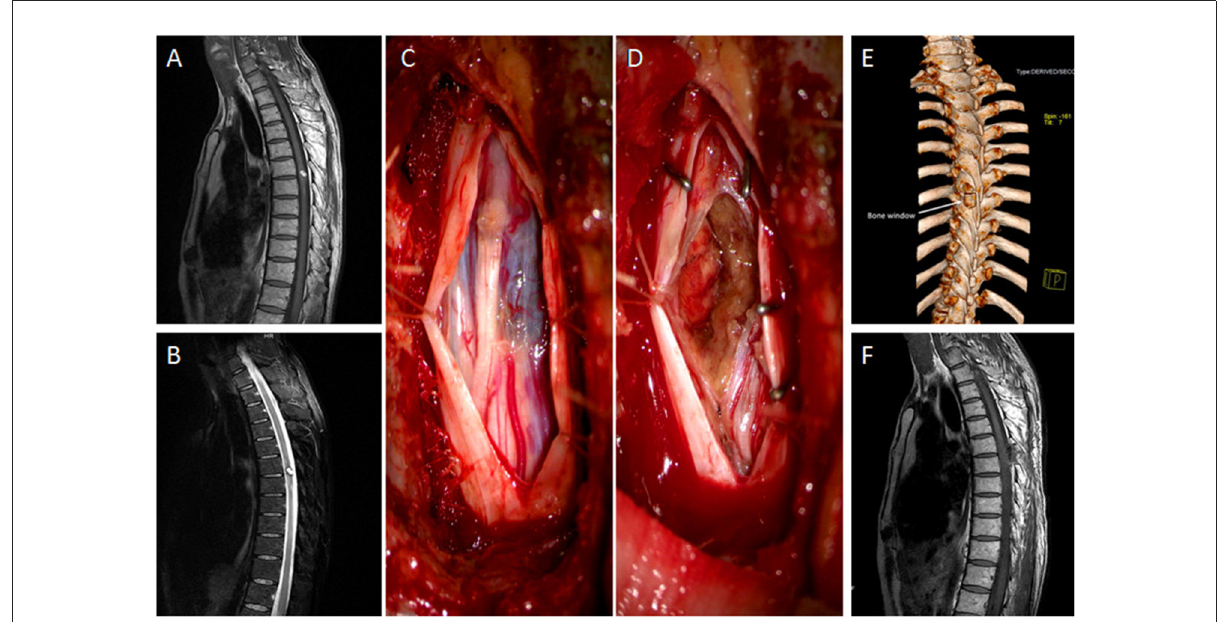
FIGURE1 (A, B) The sagittal views of MRI showed mixed heterogenous signal intensity of the central core on T1-weighted image and peripheral hypointense ring of hemosiderin on T2-weighted image in the midline of the dorsal surface in the T6–7. (C) The tumor was exposed, with blue surface in the dorsal of the spine. (D) The tumor was removed. (E) The bone window in postoperative 3D CT scan was evident after 2 left laminae excised. (F) MRI taken after 6 months in sagittal view with no tumor residual or